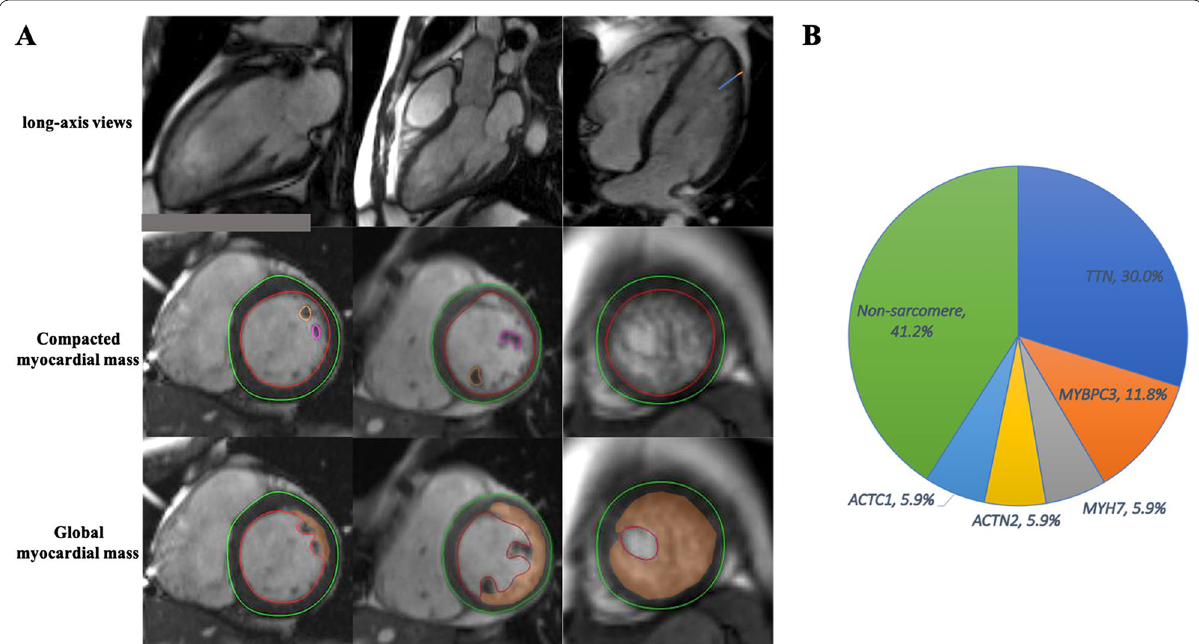
Fig. 1 CMR characteristics and genetics in LVNC. a The orange line identifies the thickness of the compacted layer, and the blue line identifies the thickness of the trabeculated layer. Standard epicardial contours (green line) and endocardial contours (red line) for measurement of the compacted myocardial mass and the papillary muscles (yellow line, pink line) were included from the measurements. Endocardial contours (red line) at the border of the non-compacted myocardium for measurement of the ‘global myocardial mass.’ The non-compacted mass (orange region) was subsequently calculated by subtracting compacted mass and papillary muscle mass from global LV myocardial mass. b Spectrum of pathogenic variants in this